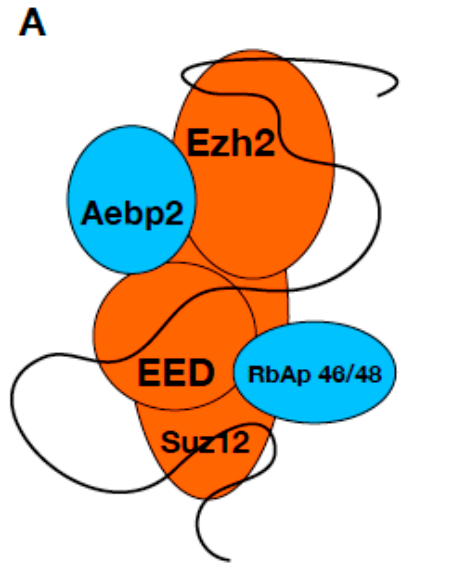
Figure 4. lncRNA binding of PRC2 and MLL4/COMPASS complex. Schematic representation of the PRC2 ( A ) and MLL4/COMPASS ( B ) complexes, where the known RNA binding subunits are shown in orange and the suggested lncRNA binding subunit MLL4 is green. Subunits currently not known to be involved in lncRNA binding are blue and the lncRNA is represented by a black line. Suggested lncRNA-MLL4 interaction is indicated by dashed line.